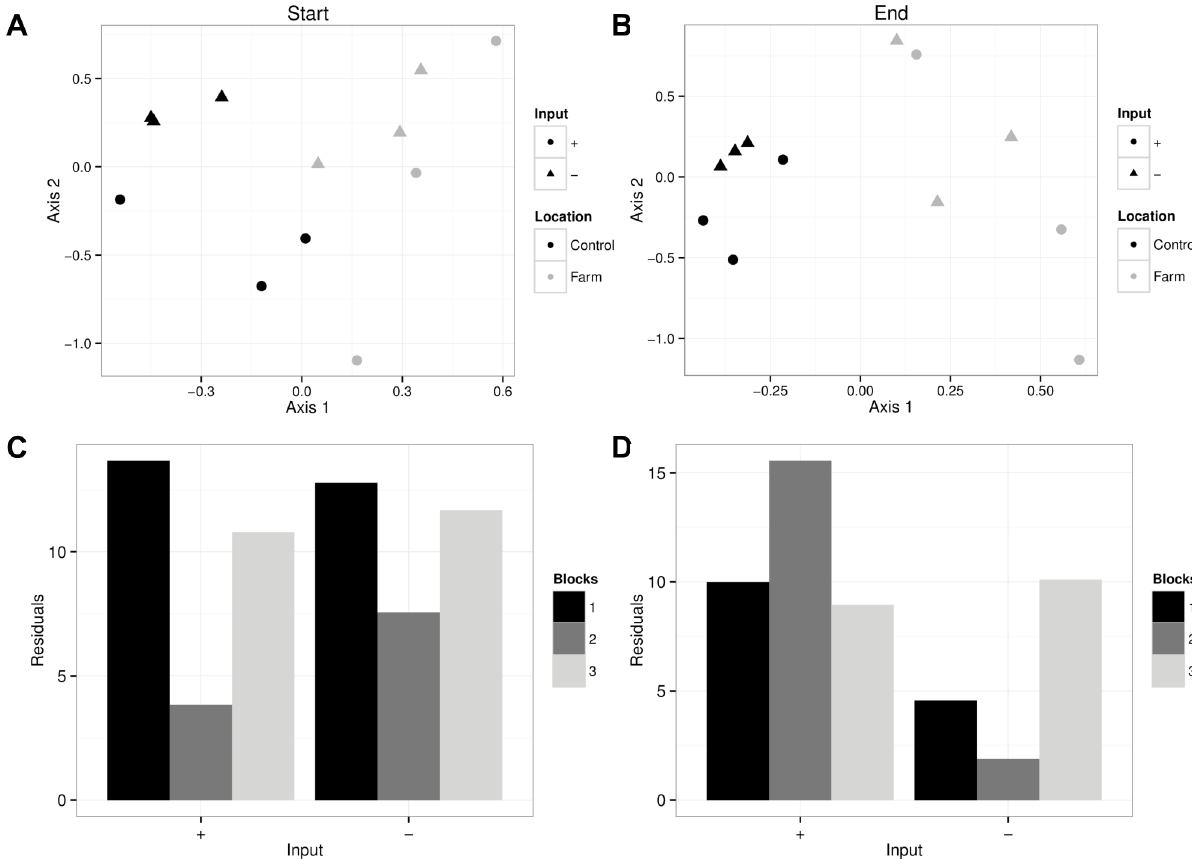
Fig 7. Redundancy analysis (RDA) of the zooplankton community composition at A) the start and B) end of the experiment. In both cases, the first axis is associated with location and is the only significant axis. B and D show the residuals from a Procrustes analysis comparing farm sites to reference sites at the start and end of the experiment respectively, showing no apparent difference in residuals related to the mussel injection treatment (- and + inputs).